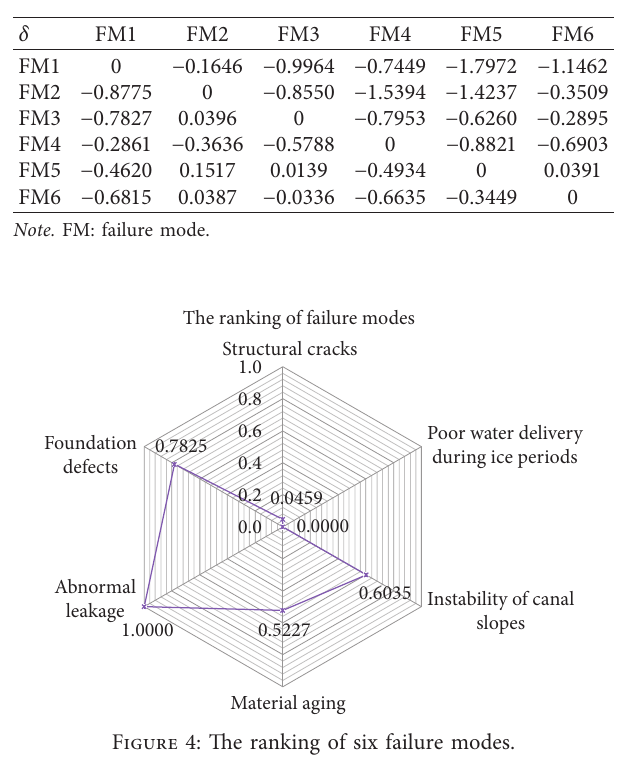
Table 7: Ranking comparison result.